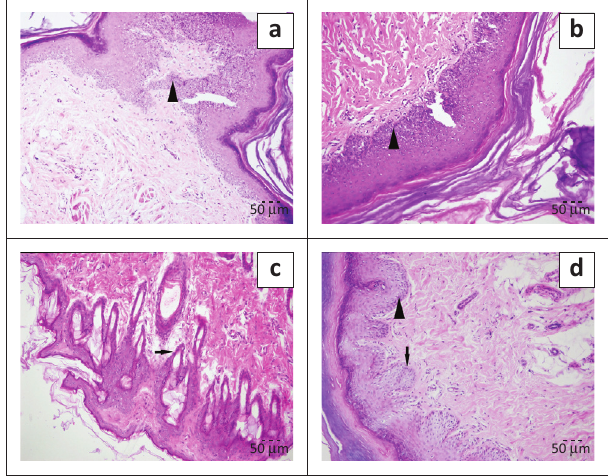
FIGURE 3: Bacterial counts in different types of bedding for male and female rats ( n = 24 male + 24